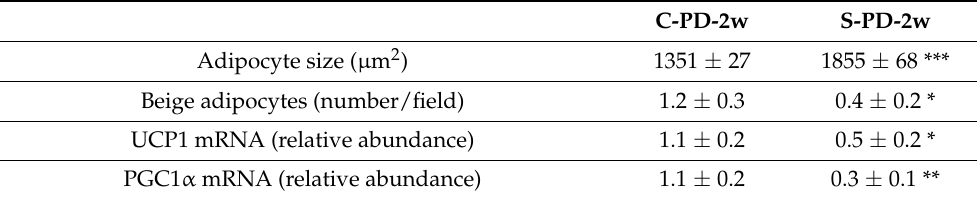
Table 1. Effect of palatable diet on adipocytes morphology and